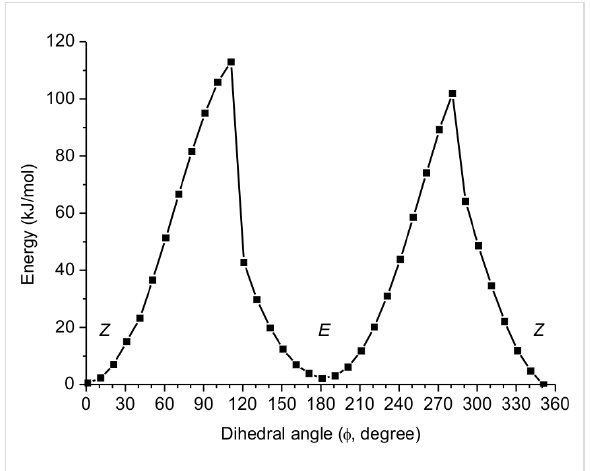
Figure 5: Potential energy surface scan graph for the dihedral angle O–C–N–C1 ( ) in 4 (BP-D3/def2-SVP). The final values for the relative Gibbs free energies for E - 4 , Z - 4 , TS1, and TS2 are given in Table 1. The difference between the E - and Z -isomer of 4 is predicted to be 3.2 kJ/mol in hexane and 5.8 kJ/mol in vacuo, respectively. The transition states are